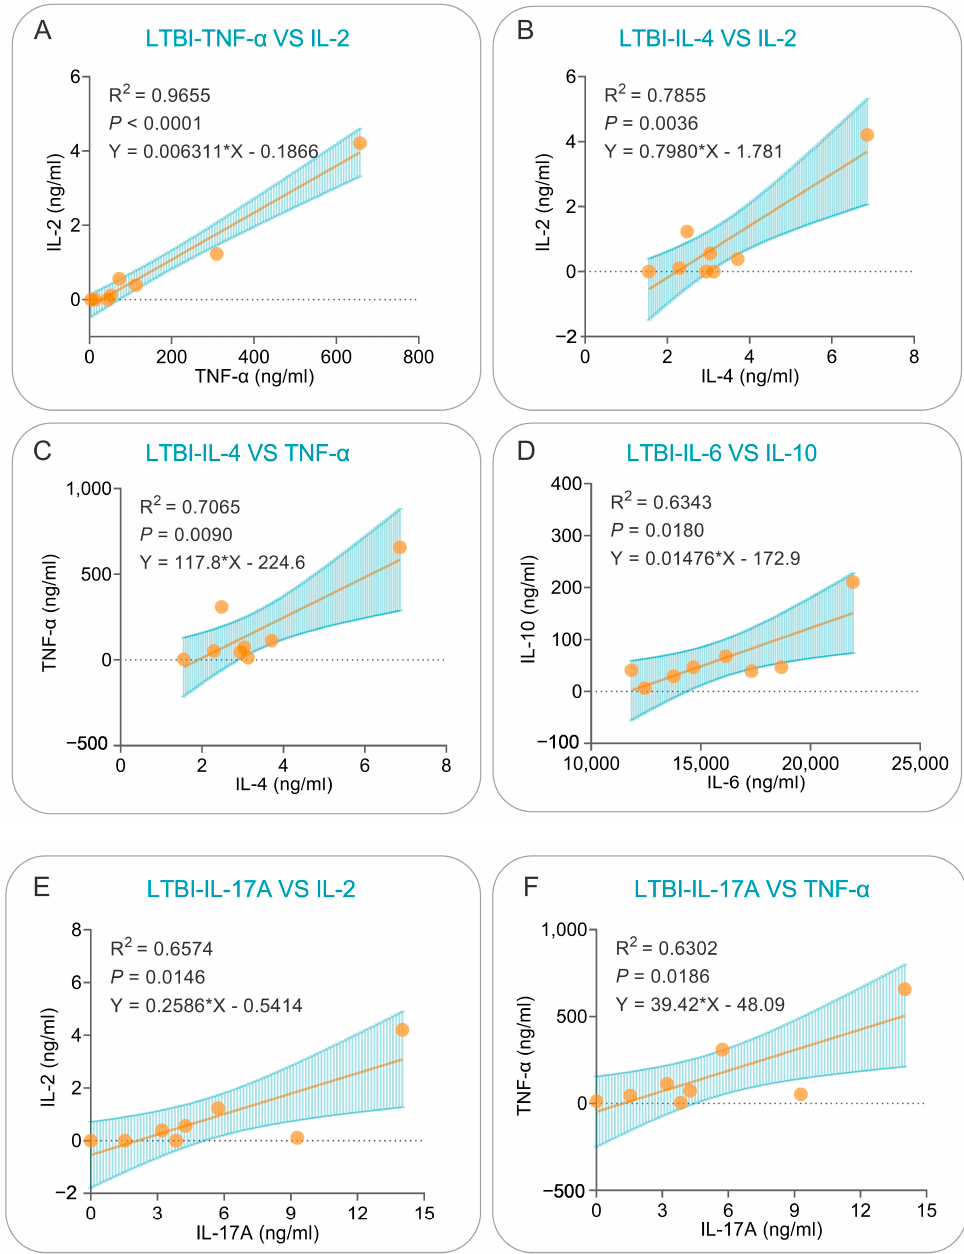
Figure 12. Simple linear regression analysis of cytokines in the LTBI population. Correlations for TNF- α vs. IL-2 ( A ), IL-4 vs. IL-2 ( B ), IL-4 vs. TNF- α ( C ), IL-6 vs. IL-10 ( D ), IL-17A vs. IL-2 ( E ), and IL-17A vs. TNF- α ( F ) were analyzed using simple linear regression in GraphPad Prism 9.5.1 software. The R-squared values for the goodness of fit, p values, and equations are shown in each panel. A p value lower than 0.05 was considered